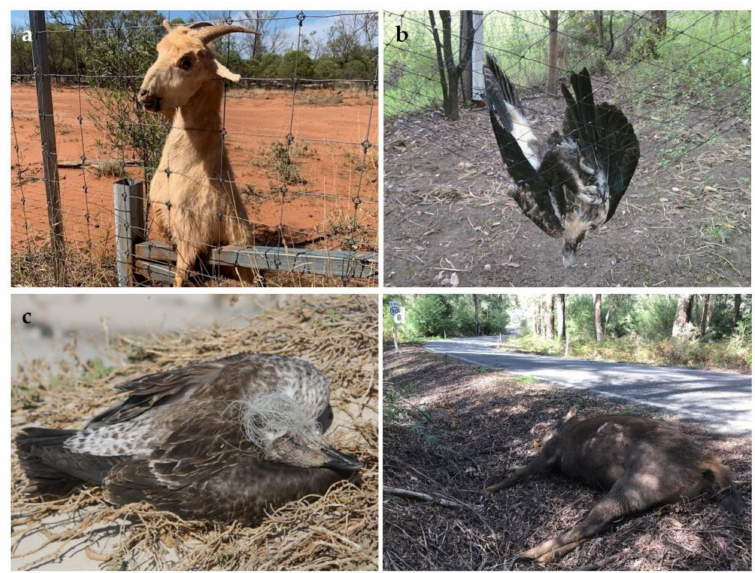
Figure 1. Examples of Type 3 harms affecting wild animals as a result of food production: ( a ) A feral goat ( Capra hircus ) caught and killed in livestock fencing; ( b ) A wedge-tailed eagle ( Aquila audax ) caught in horticultural netting; ( c ) A kelp gull ( Larus dominicanus ) entangled in fishing line; ( d ) A sambar deer ( Rusa unicolor ) struck and killed by a truck used for food transportation. (Photos: Benjamin Allen, Gary Williams, Peter Ryan, Jordan Hampton).